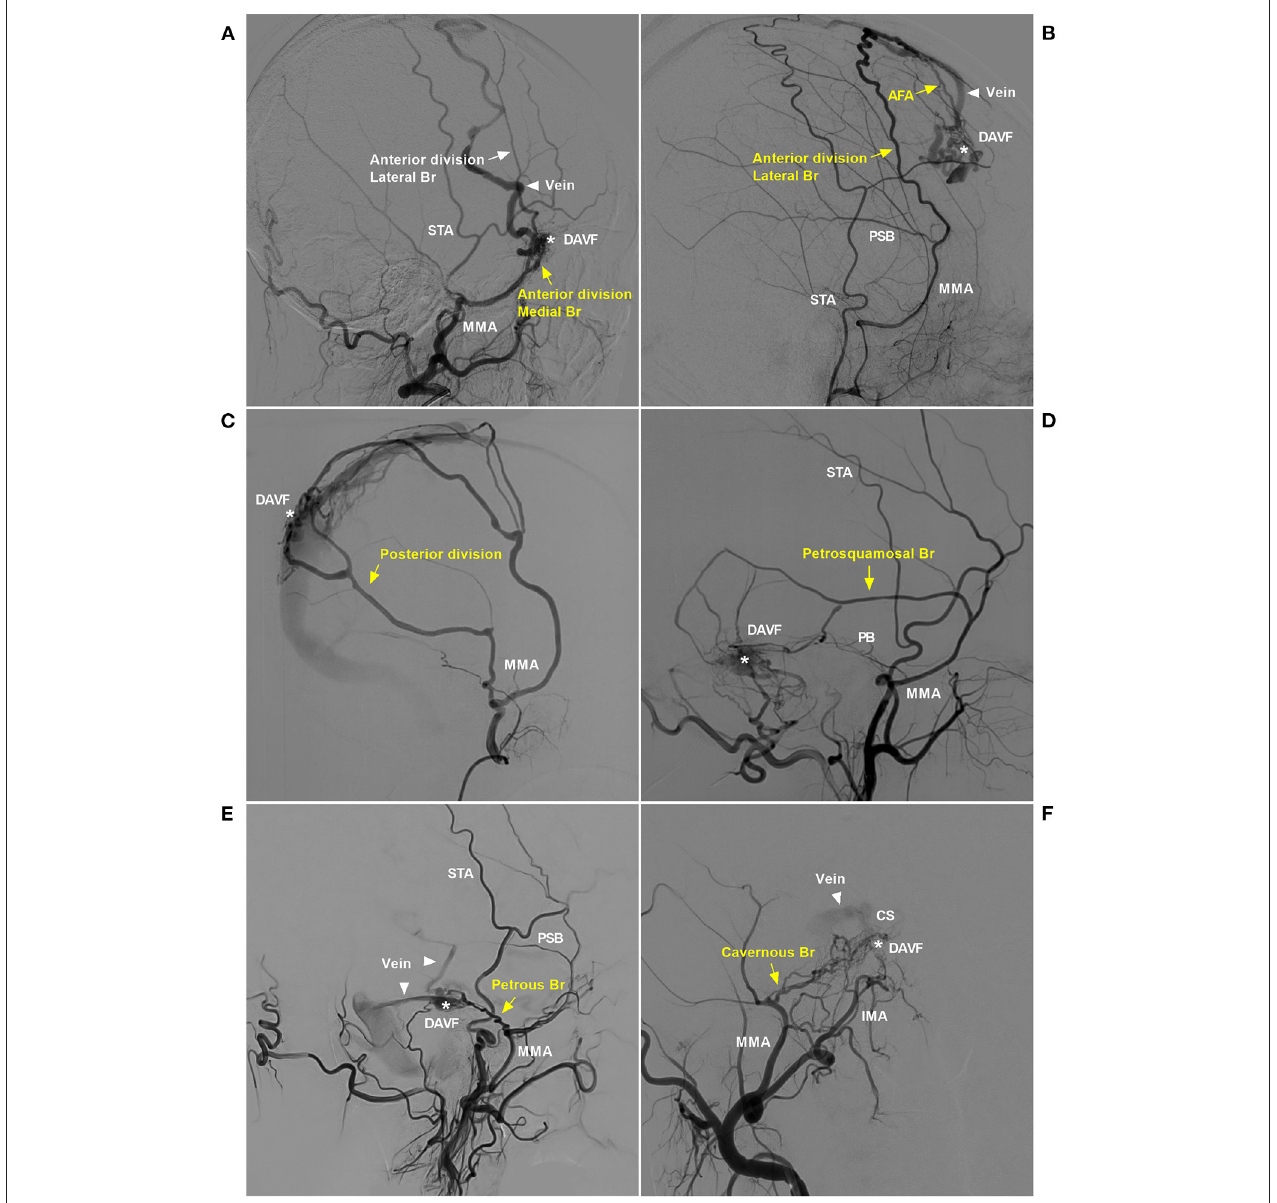
FIGURE 2 | Pathological anatomy of the MMA as a DAVF feeder. (A) DSA of the lateral view showed the sphenoid wing DAVF (asterisk) fed by the medial branch (sphenoid) of the anterior division of the MMA (yellow arrow) draining to the SSS (triangle). (B) DSA of the lateral view showed a DAVF (asterisk) at the anterior falx cerebri fed by the lateral branch of the anterior division of the MMA (yellow arrow) that reached the midline and anastomosed with the AFA (yellow arrow). The DAVF drained through the cortical vein (triangle) to the SSS. (C) DSA of the lateral view showed that the posterior division of the MMA supplied the DAVF (asterisk) at the SSS. (D) DSA of the lateral view showed that the PSB of the MMA (yellow arrow) supplied the TSS DAVF (asterisk). (E) DSA of the lateral view showed that the PB of the MMA (yellow arrow) supplied the tentorium DAVF (asterisk), and the triangles indicate the draining veins. (F) DSA of the anterior posterior view showed the CS DAVF (asterisk) supplied by the cavernous branch, and the triangle indicates the draining vein. AFA, anterior falx artery; Br, branch; CS, cavernous sinus; DAVF, dural arteriovenous fistula; DSA, digital subtraction angiography; IMA, internal maxillary artery; MMA, middle meningeal artery; PB, petrous branch; PSB, petrosquamosal branch; SSS, superior sagittal sinus; STA, superficial temporal artery; TSS, transverse-sigmoid